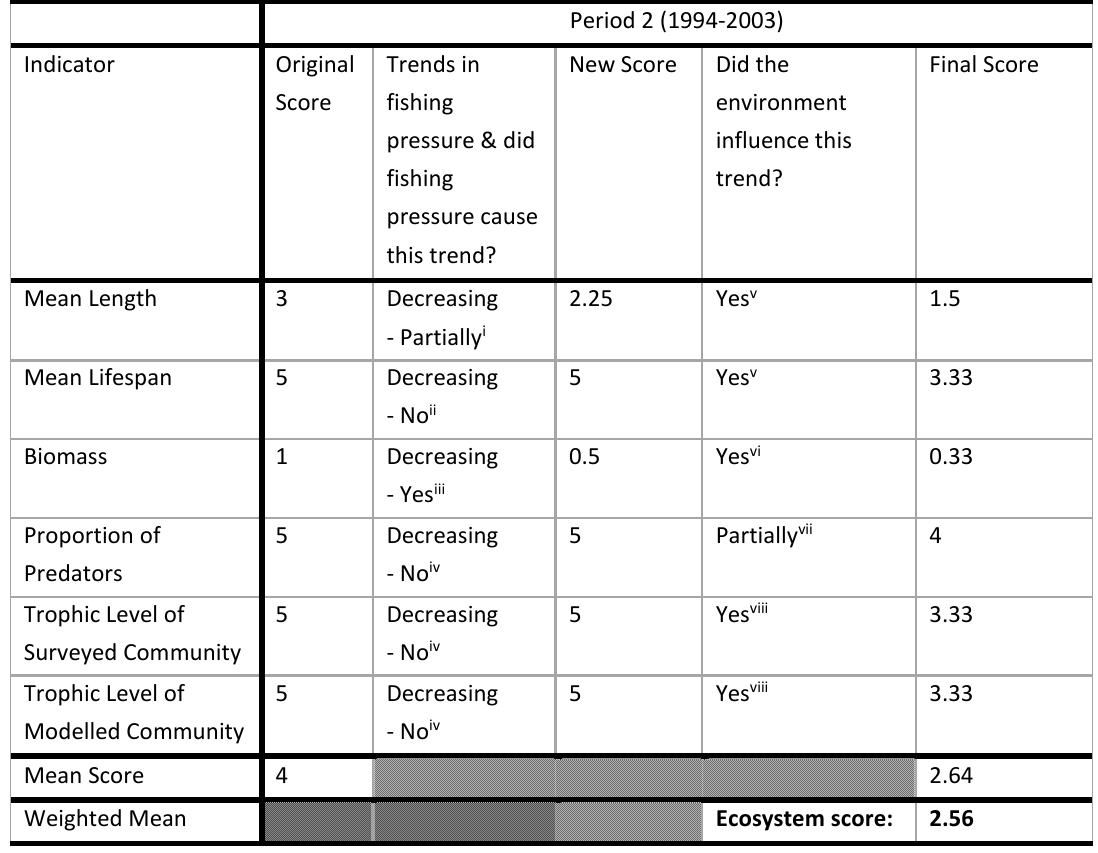
Table A1: Summary of outputs of decision tree framework for Period 2 (1994-2003) in the Southern Benguela. Scores are sequentially adjusted to account for the influences of fishing pressure and environmental variability. A weighted mean is used to account for potential redundancies and calculate a final score, classifying the ecosystem. See footnotes for details on how the observed fishing pressure and environmental indicator trends impact each indicator (Adjusted from Lockerbie et al.